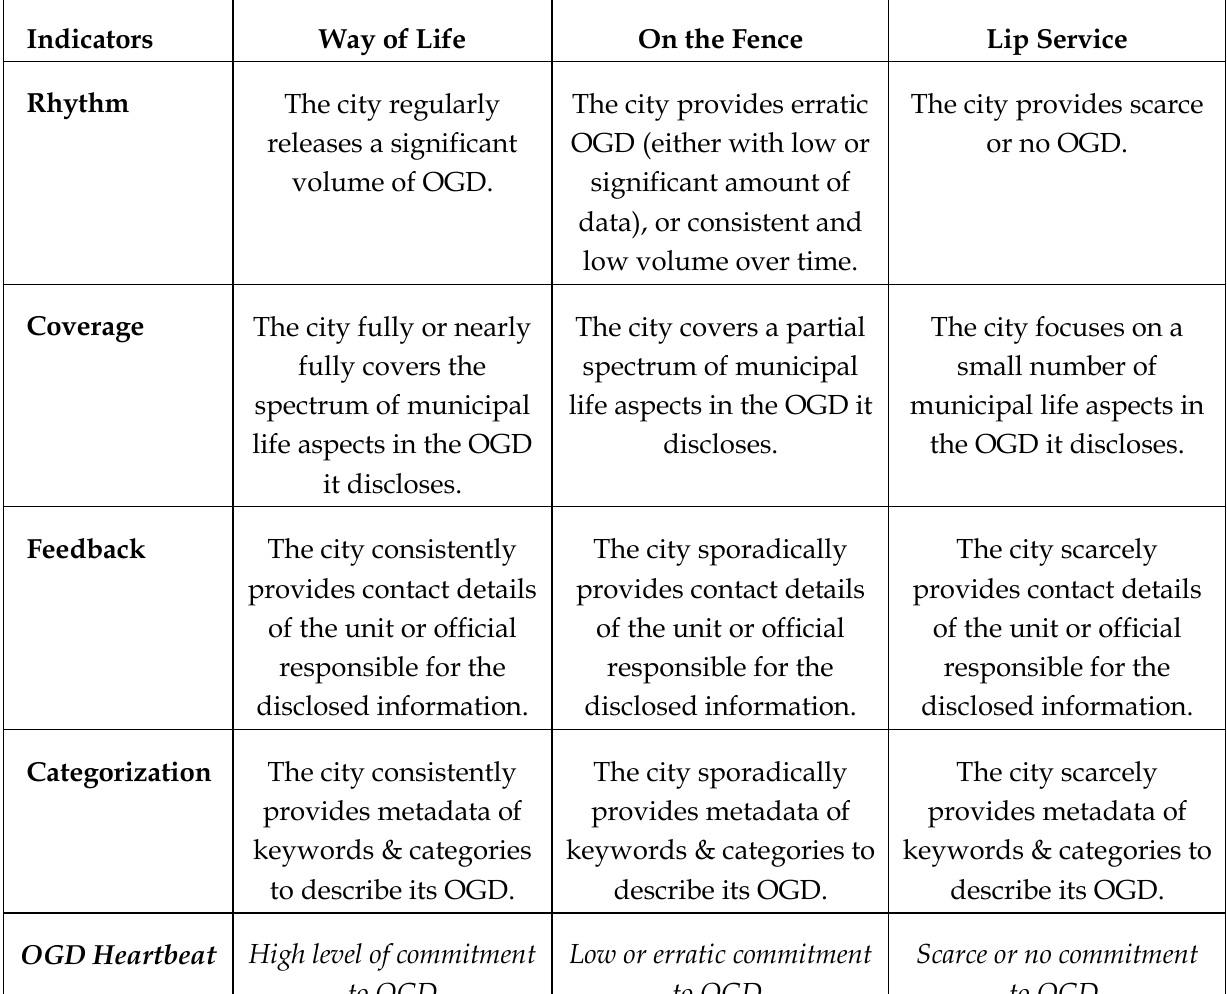
Table 1: OGD Commitment